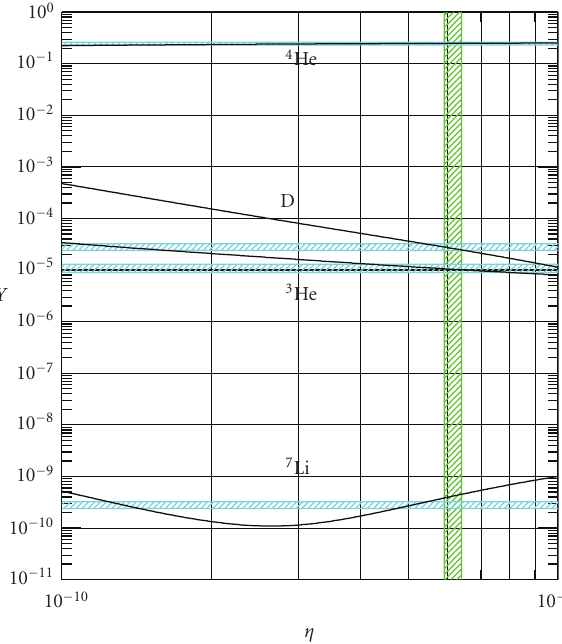
Figure 2: Light elemental abundances versus the photon to baryon ratio, η . The horizontal lines show measured abundances of the respective elements and the vertical lines show the photon to baryon ratio as measured by